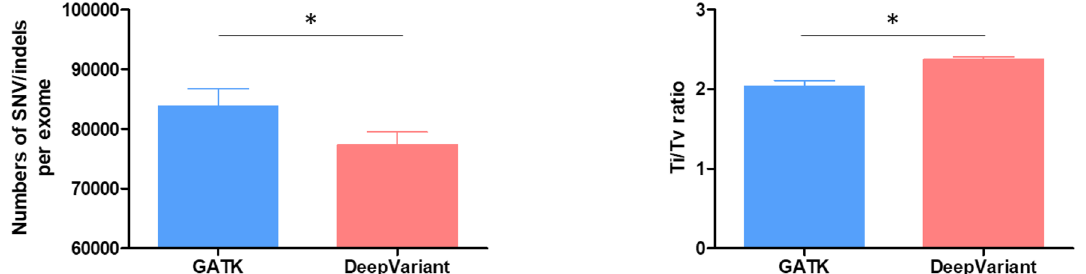
Figure 2. Numbers of SNVs/indels and Ti/Tv ratios from the 2 different pipelines (n = 77